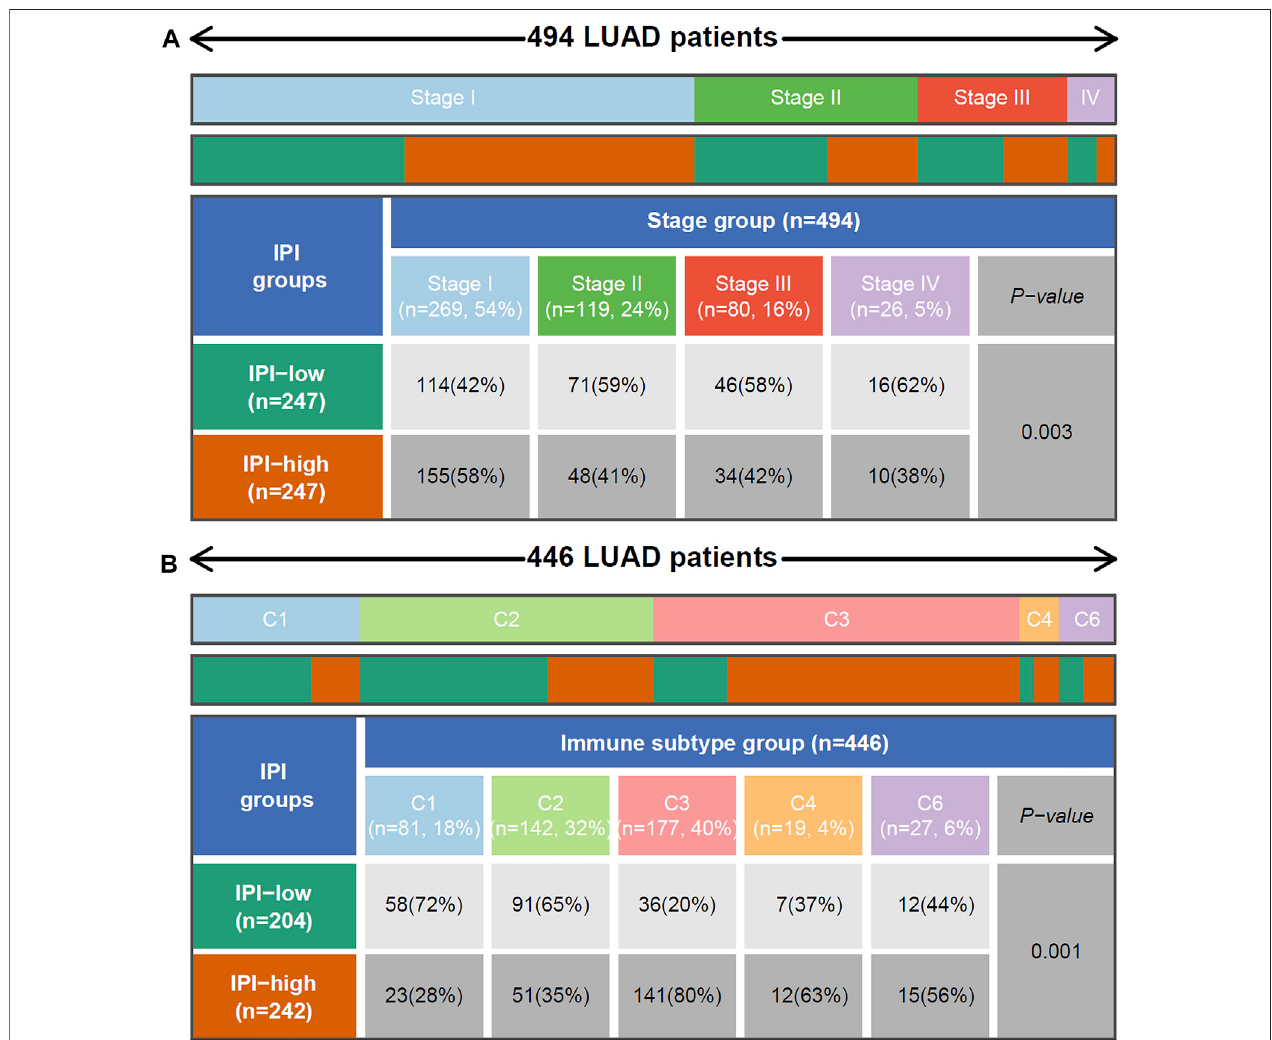
FIGURE 5 | Relationship between IPI and tumor stage and reported immune subtype. (A) Heat map and table showing the distribution of LUAD tumor stage between IPI subgroups. (B) Heat map and table showing the distribution of LUAD immune subtype (C1, C2, C3, C4 and C6) between IPI subgroups. C1: Wound Healing, C2: IFN- γ Dominant, C3: In fl ammatory, C4: Lymphocyte Depleted and C6: TGF- β Dominant. The distributions of tumor stage and reported immune subtype in the IPI subgroups were compared through the chi-square